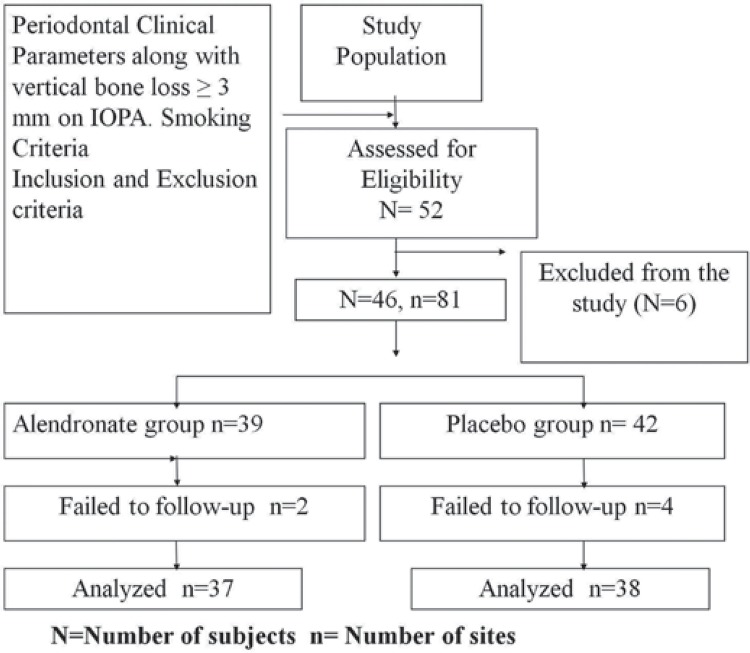
Study flow chart